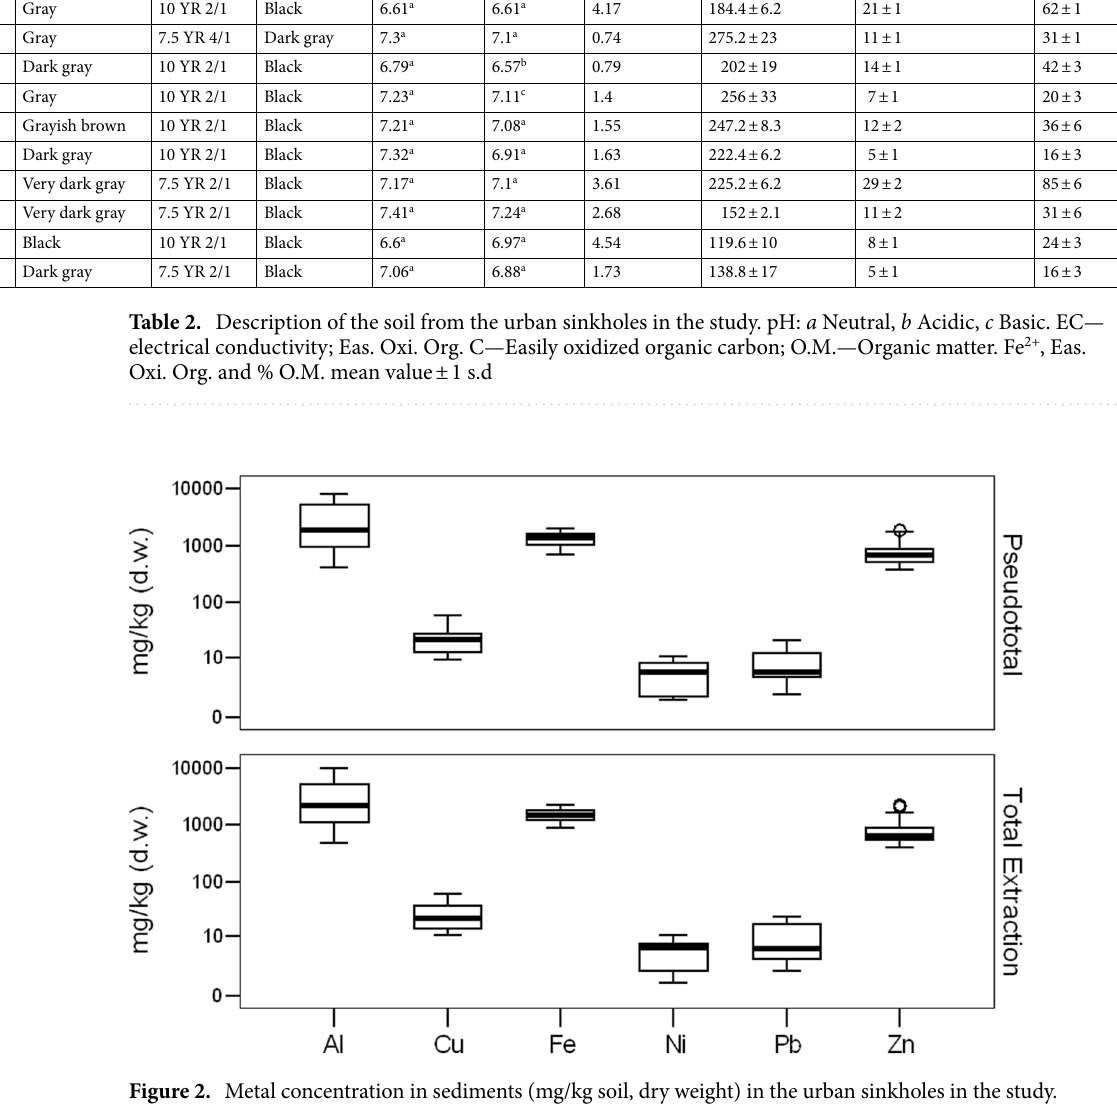
Figure 2. Metal concentration in sediments (mg/kg soil, dry weight) in the urban sinkholes in the